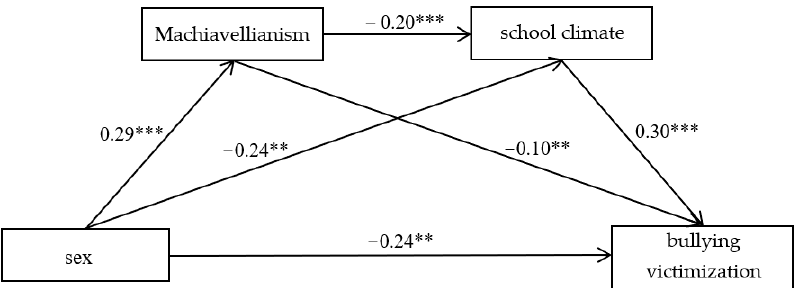
Figure 3. The chain-mediating effect of Machiavellianism and school climate between sex and bullying victimization. Note: ** p < 0.01, *** p < 0.001